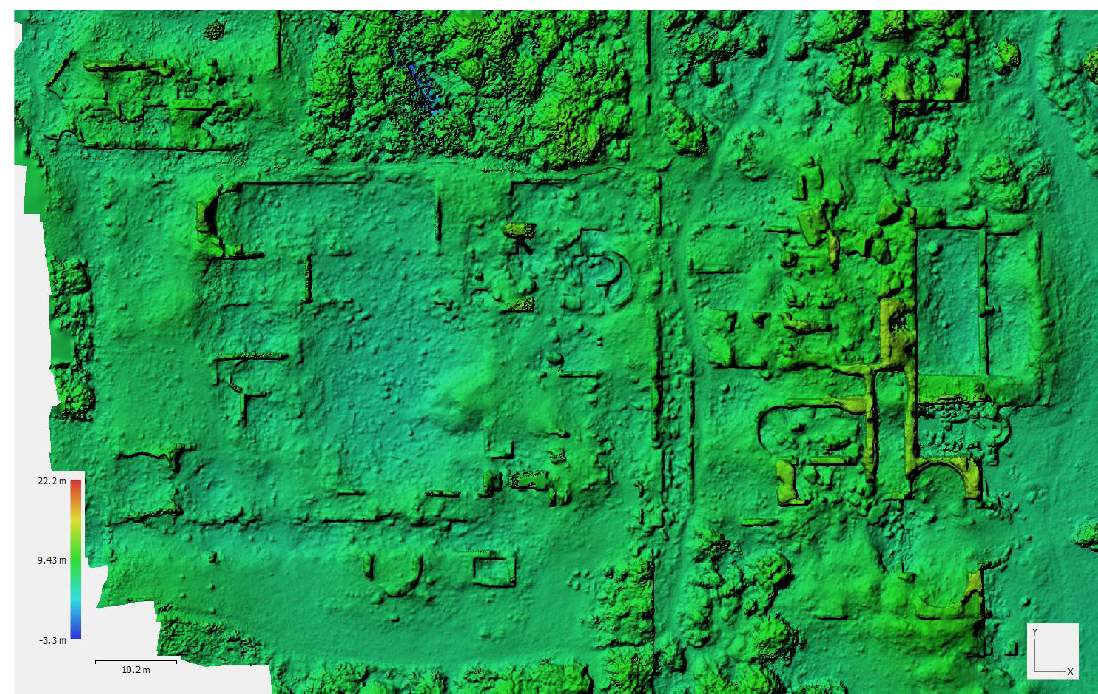
Figure 9.4. DEM view (© M. Hernández